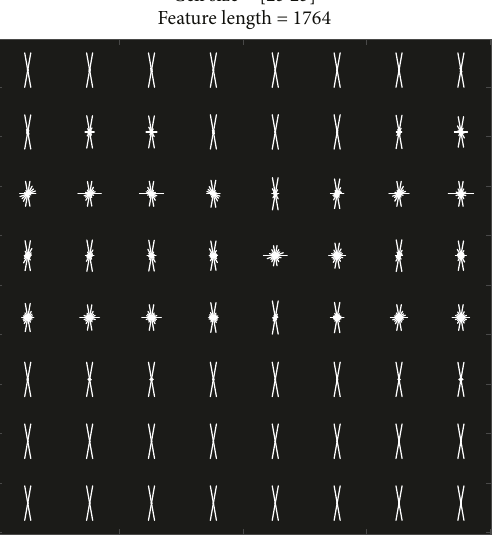
Figure 8: Visualization of the HOG feature.